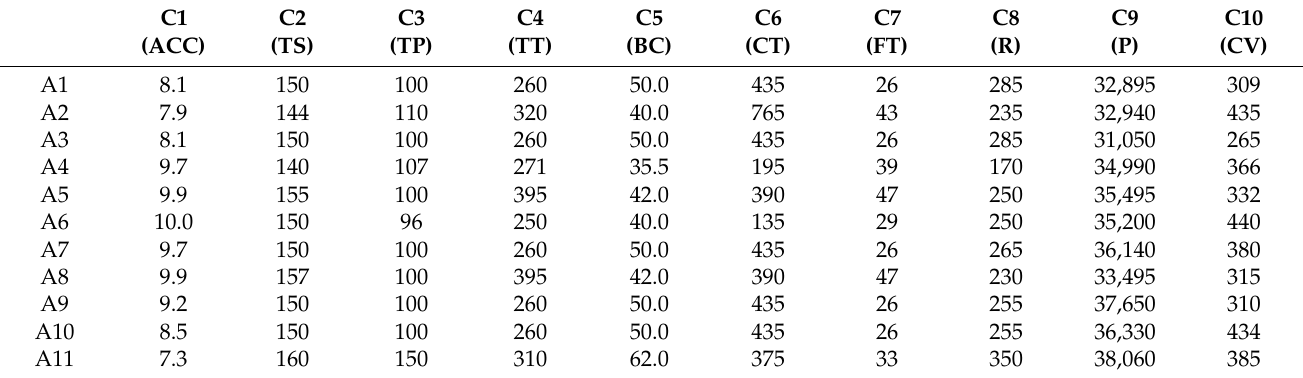
Table 5. Initial decision matrix.